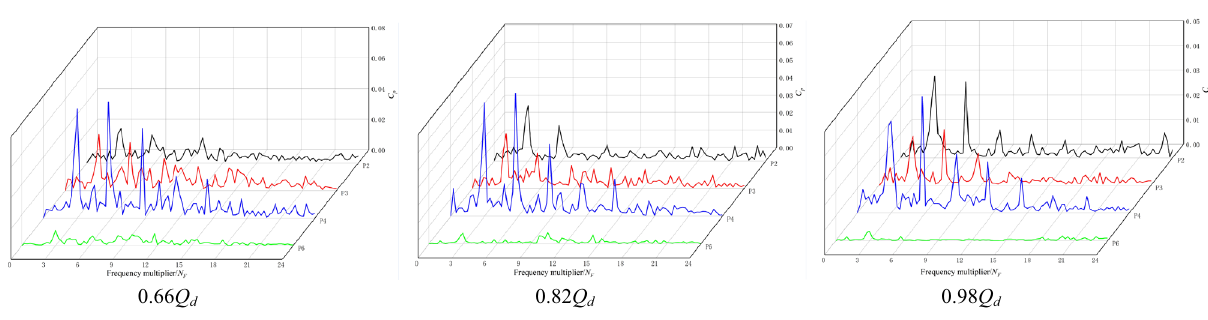
Figure 12. Frequency domain diagram of pressure fluctuation under the